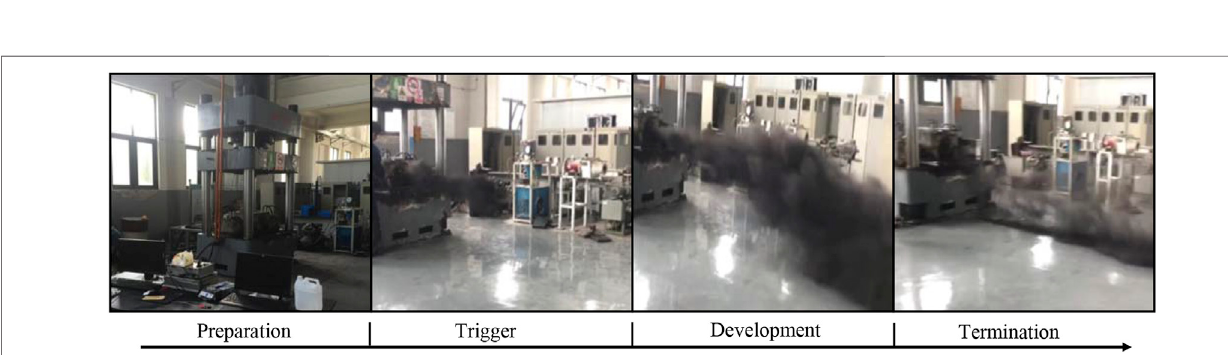
FIGURE 7 | The process of coal and gas outburst in simulation tests.